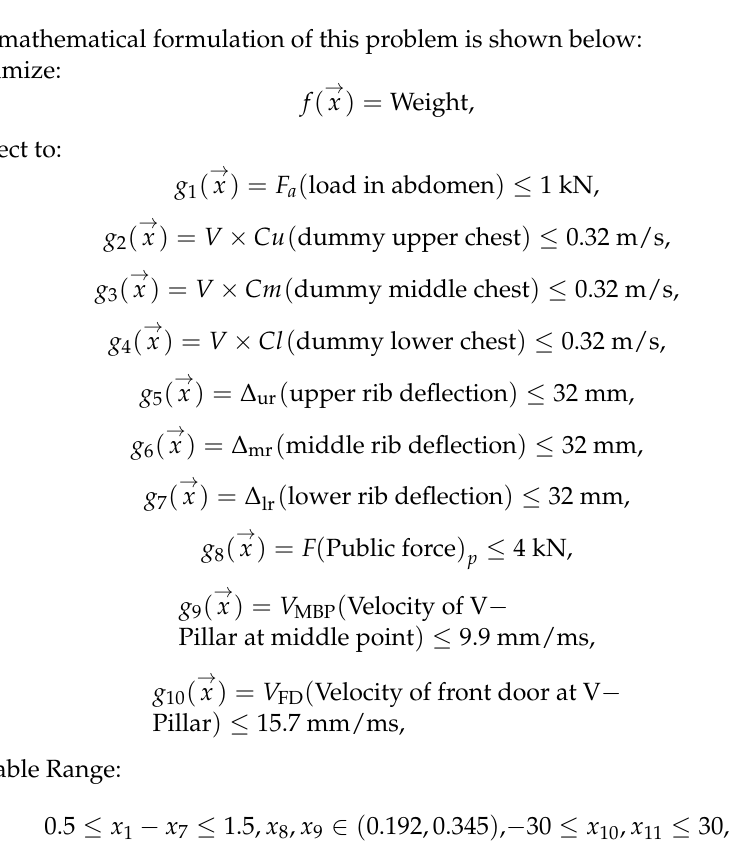
Figure 14. Three-dimensional model diagram of a car’s side crash.